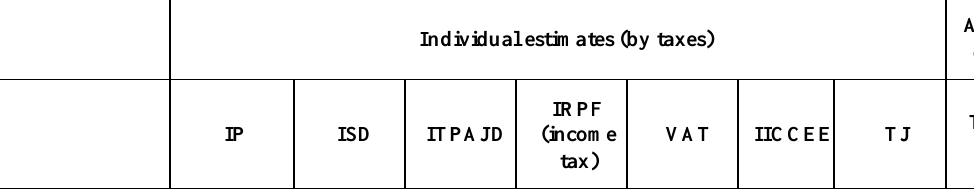
Table A.3 : General and specific indexes of tax capacity (Regressions using Driscoll-Kraay standard errors for the 2002-2012 period) Individual estimates (by